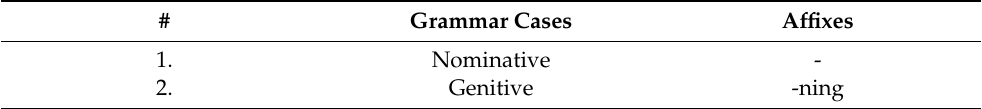
Table 9. Result of stemming adjectives.